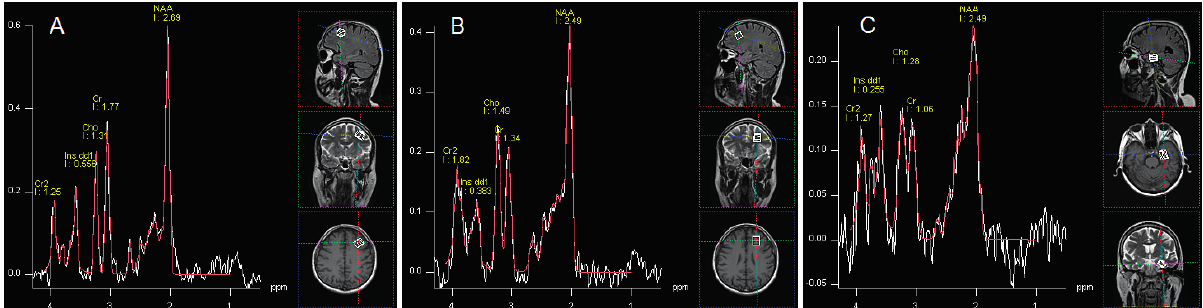
Figure 1. Images showing voxel location in the left DLPFC area ( A ), left frontal WM ( B ), left ( C ) and an examples before (white line) and after (red line) fitting. Peak areas for N -acetylaspartate (NAA); creatine (Cr and Cr2); choline (Cho); and myo-inositol (mI dd1) are